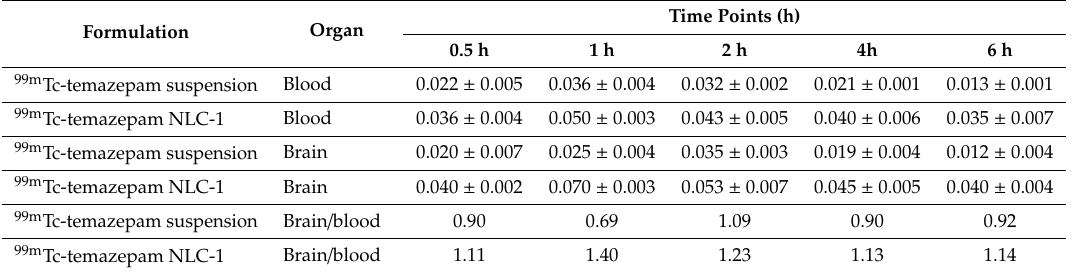
Table 5. Distribution of temazepam in blood and brain at different sampling time points.